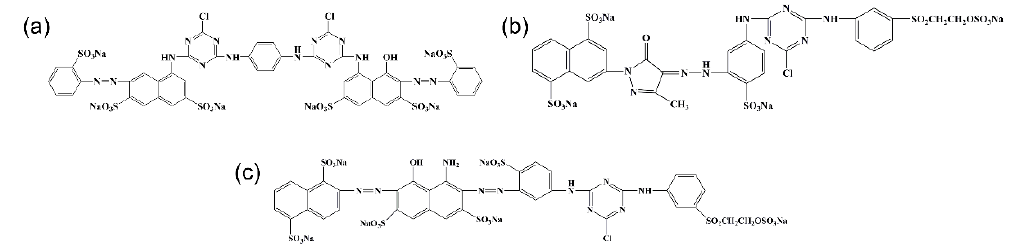
Figure 1. Chemical structures of ( a ) RR120, ( b ) RY167, and ( c ) RB222, respectively.